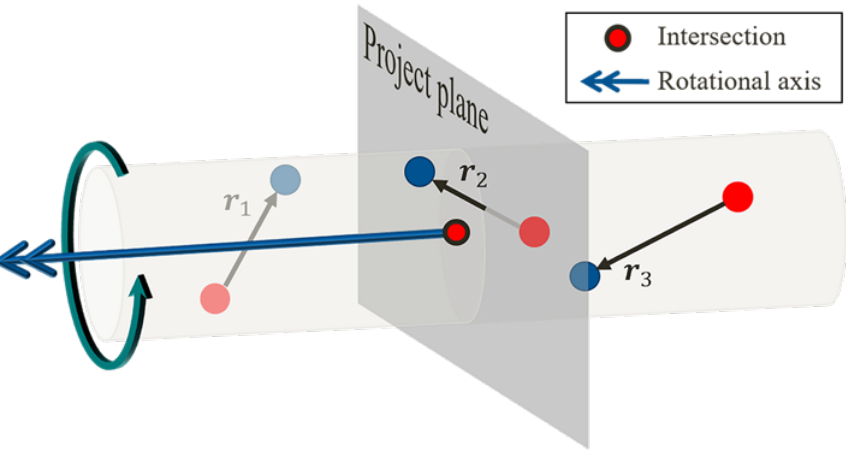
Figure 8. Invert the rotational point to 3-D coordinate.